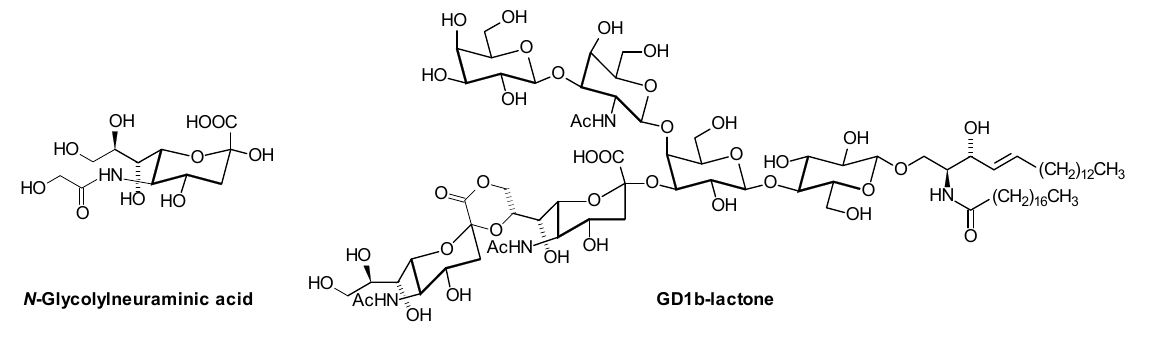
Figure 3. N -Glycolylneuraminic acid (Neu5Gc;  -configuration) and an example of a